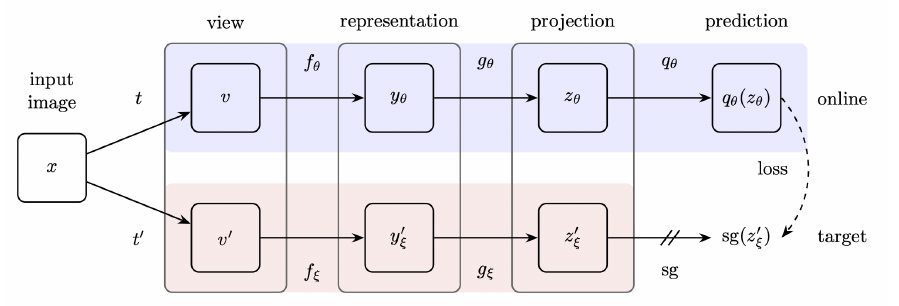
Figure 18. BYOL architecture (https://paperswithcode.com/paper/bootstrap-your-own-latent-a- new-approach-to-1), accessed on 15 September